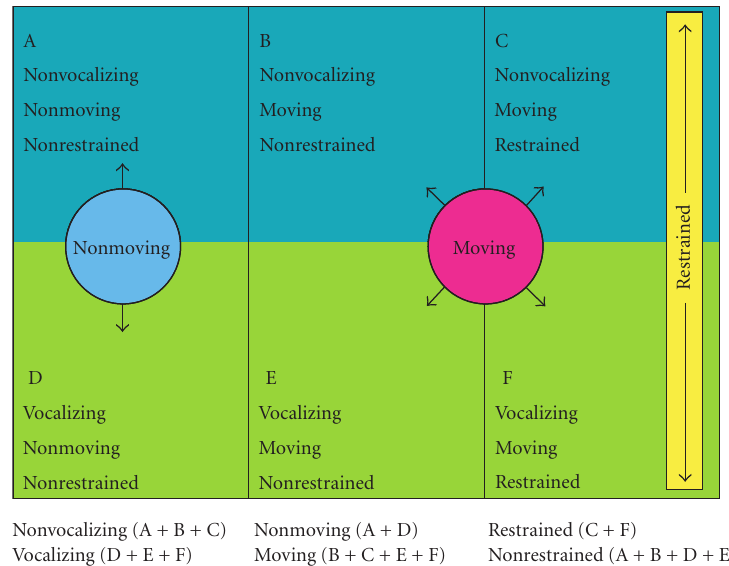
Figure 1: Explanation of variables in the Ohio State University Behavioral Rating Scale (OSUBRS).